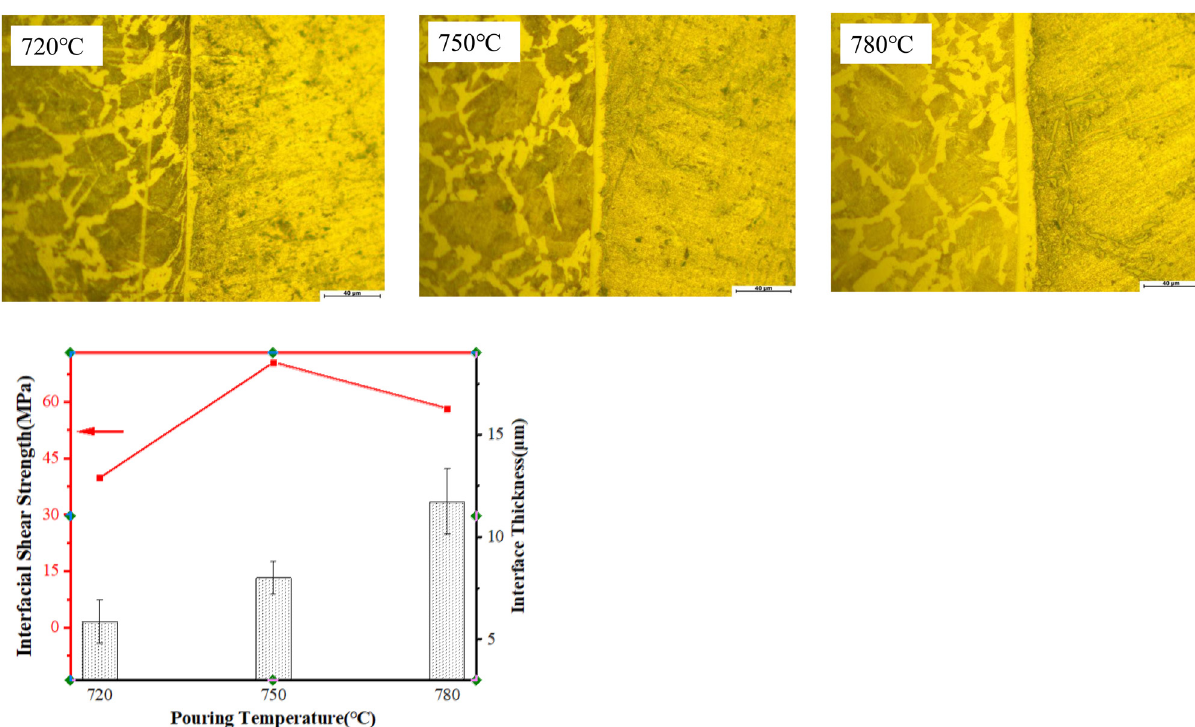
Figure 7: The relationship between the thickness of the bonding layer and the interfacial shear strength at di ff erent pouring